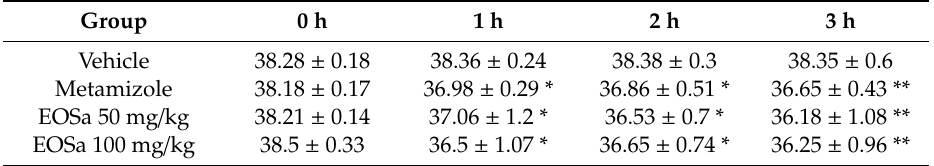
Table 2. E ff ect of S. aromaticum essential oil on fungi-induced fever. Group 0 h 1 h 2 h 3 h Vehicle 38.28 ± 0.18 38.36 ± 0.24 38.38 ± 0.3 38.35 ± 0.6 Metamizole 38.18 ± 0.17 36.98 ± 0.29